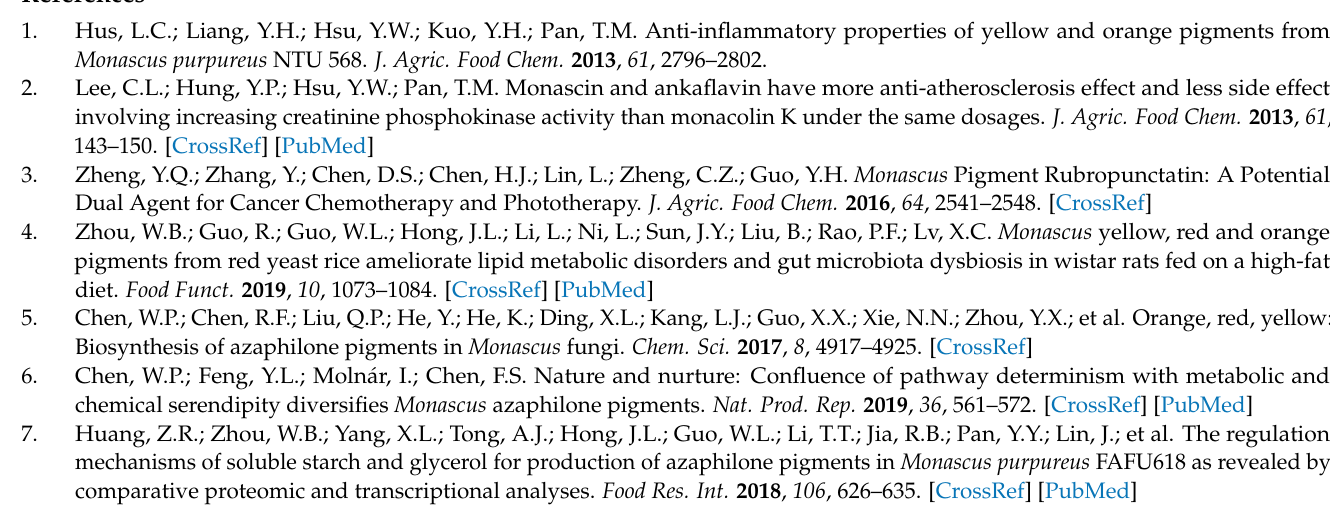
Table S3: Annotated number of expressed genes; Table S4: Expression of key genes for Monascus pigments secondary metabolism; Figure S1: Hierarchical cluster plot base on PCA; Figure S2: Heat map of pearson correlction of genes and transcripts between Con and T11); Supplementary material S2 includes (Table S1: Analysis of nonredundant (Nr) classification; Table S2: Analysis of KEGG classification; Table S3: The up-/down-regulated of KEGG